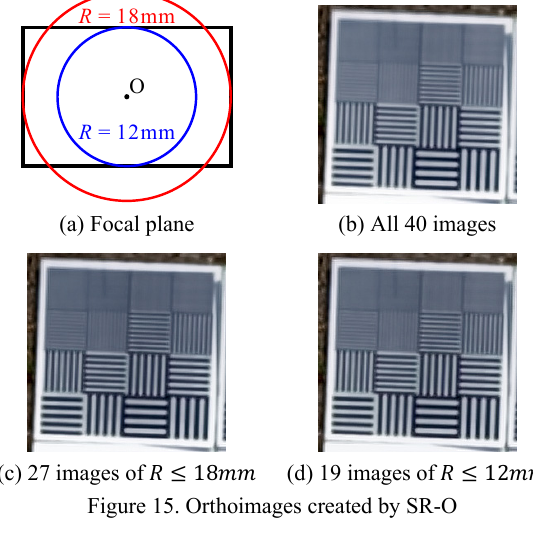
Figure 15. Orthoimages created by